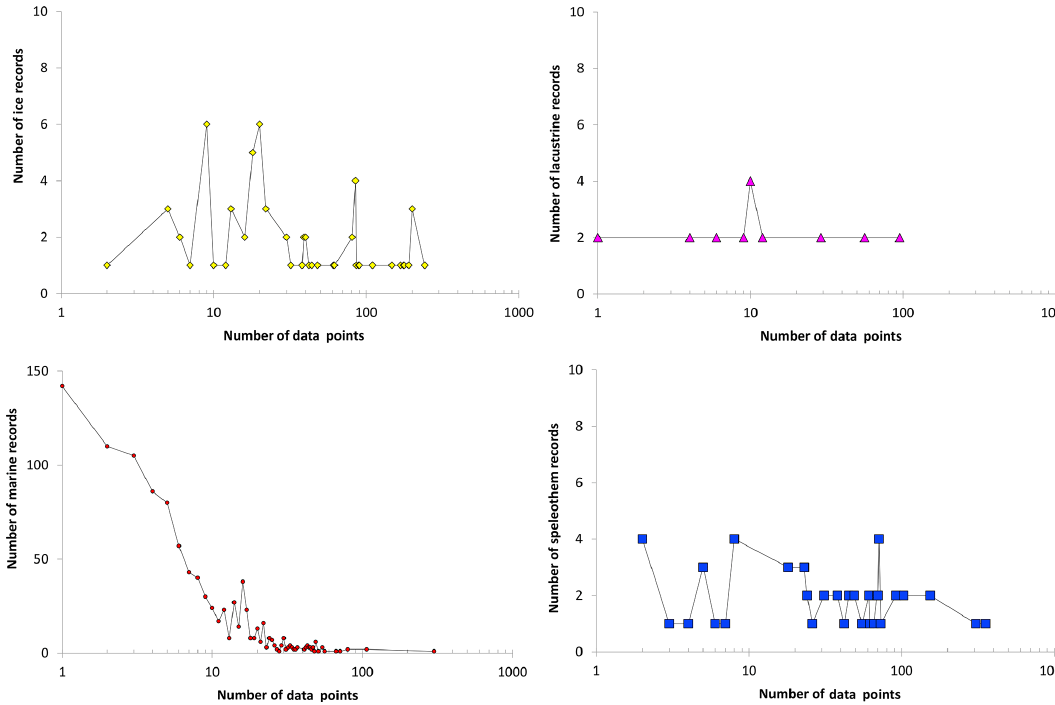
Figure A3. Same as Fig. 1 but for the LGM (19–23ka). Note the different vertical